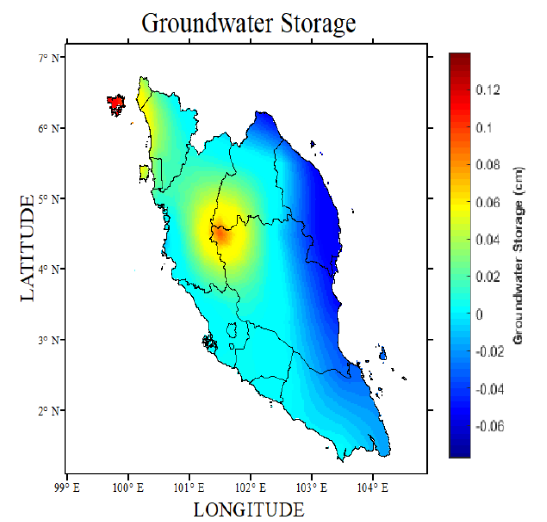
Figure 1. The average of GWS in the Peninsular Malaysia region from 2002 until 2017